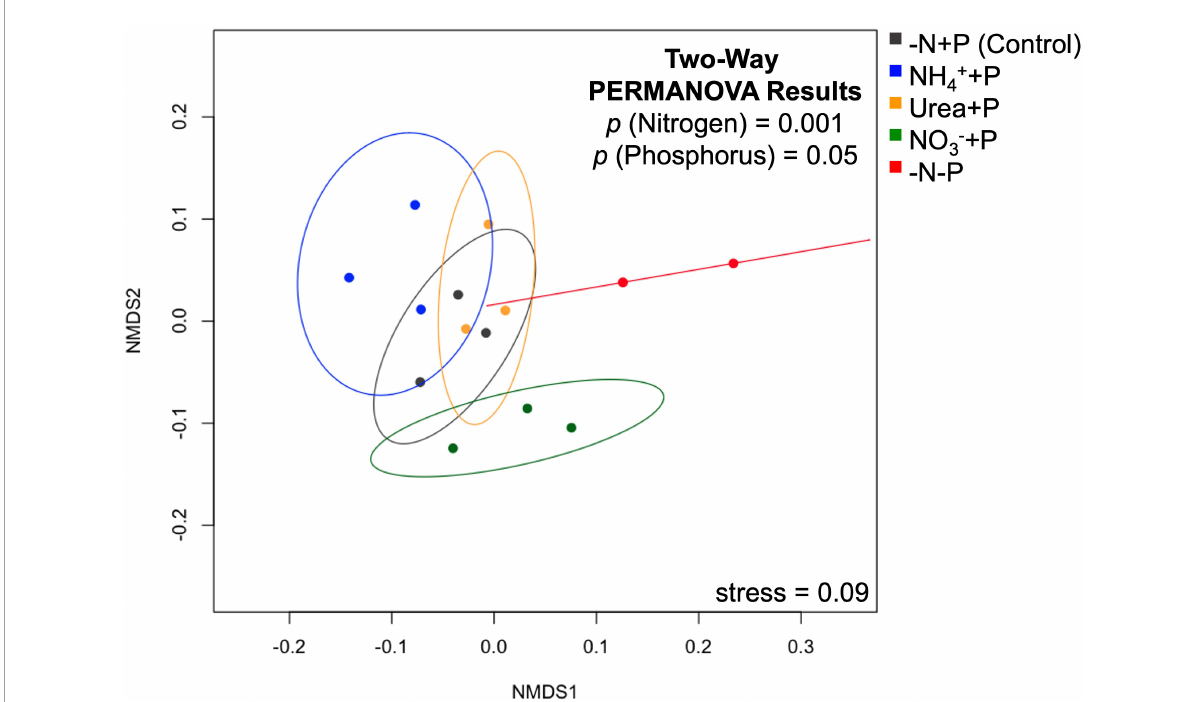
FIGURE5 Non-metric multi-dimensional scaling (nMDS) plot of normalized read counts among treatments mapped to the Trinity assembly. Stress value in the lower left-hand corner indicates the disagreement between the plot configuration and the predicted values from the regression. Ellipses represent 95% confidence intervals, with the results of a two-way PERMANOVA ( p < 0.05) on the dissimilarity matrix of the data presented in the upper right-hand corner, representing the significance of fixed nitrogen and phosphorus availability on relative